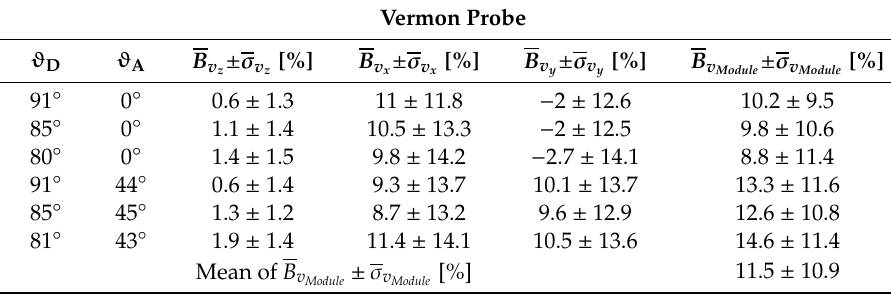
Figure 7. Velocity profiles reconstructed by Vermon acquisitions, along the line crossing the probe axis with different probe-to-flow orientations. The black solid line is the reference velocity profile. Table 3. Relative bias and mean standard deviation for